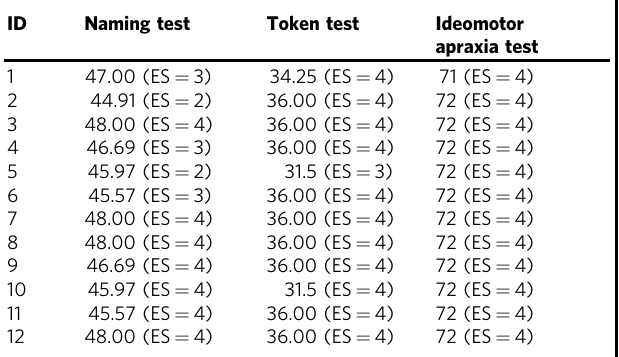
Table 2 Preoperative cognitive performance.